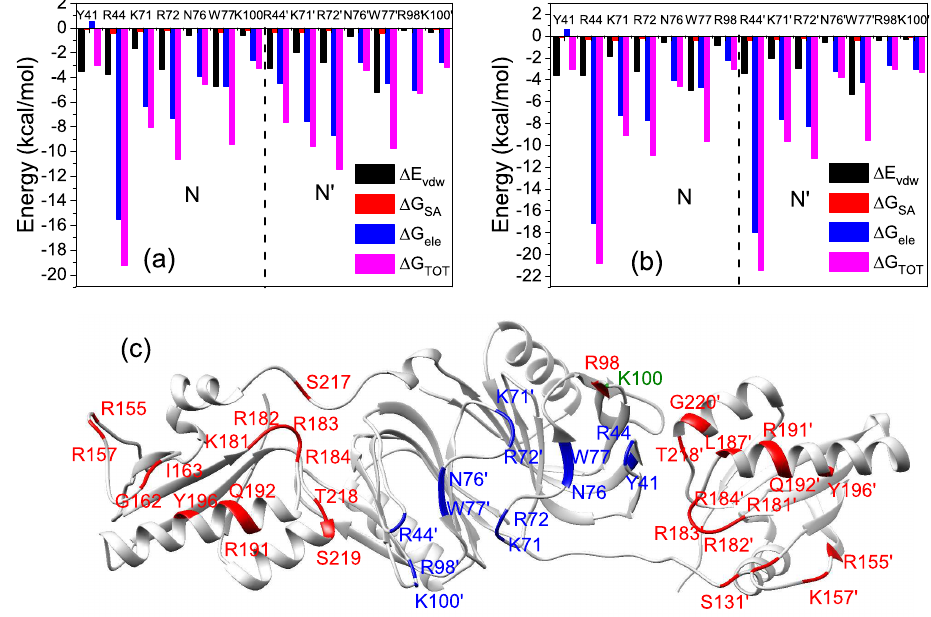
Figure 6. Residue-based decomposition of the binding free energy from the sum of electrostatic interactions and polar solvation energy ( ∆ G ele = ∆ E ele + ∆ G GB ), the van der Waals energy ( ∆ E vdw ), and nonpolar solvation energy ( ∆ G SA ) for the key residues of N-terminal domains: ( a ) M1 and ( b ) M20. ( c ) The key residues that are important for EndoMS/NucS-dsDNA interactions. The residues belonging to M1 are colored in green, those belonging to M2 are colored in red, and those belonging to M1 and M20 are colored in